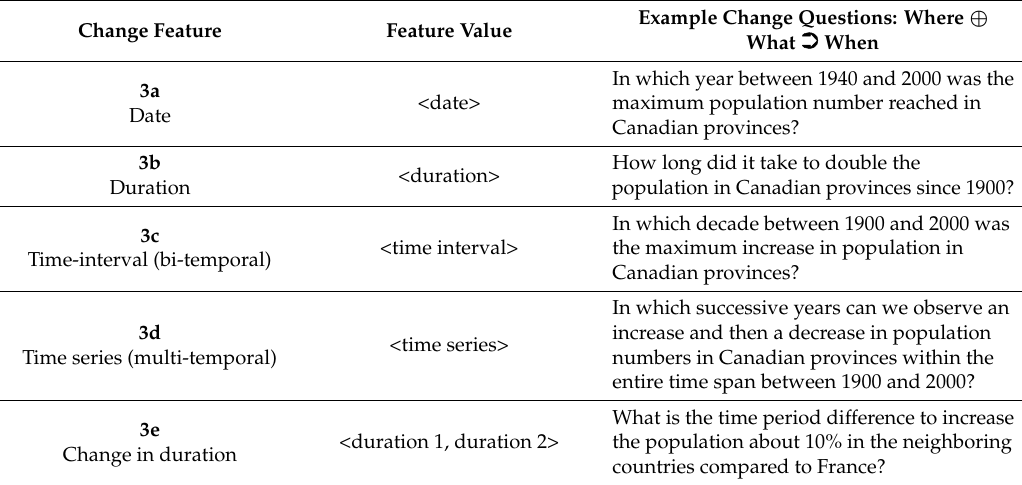
Table 3. Possible characteristics of “When” output clauses. Table 1. Characteristics of “What” output clauses.